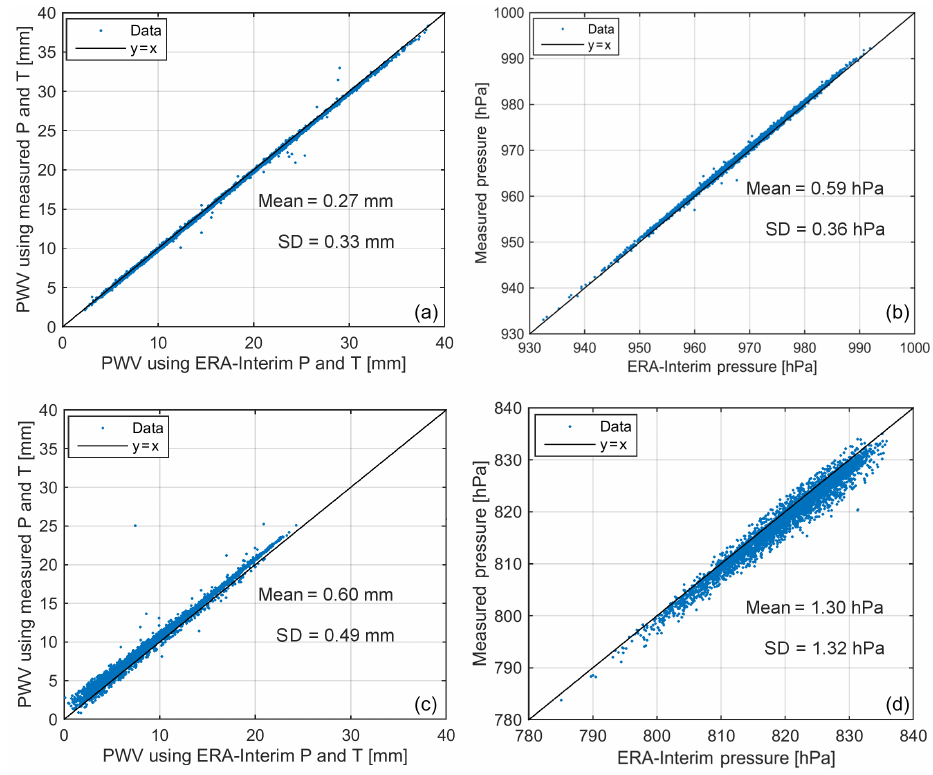
Figure 3. (a, c) PWV determined using interpolated pressure and temperature from surface measurements and ERA-Interim and the corre- sponding pressure values for the GNSS site 0522. Similarly in panels (b, d) for the GNSS site 0285.